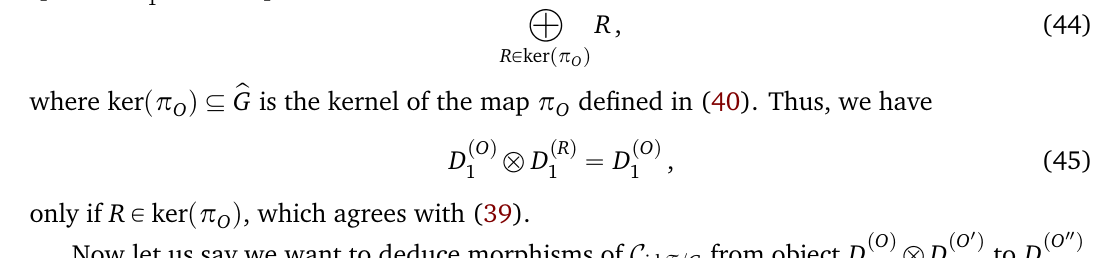
Figure 23: We can relate the morphism space D p O , R O q ter gauging G to the sub-space of the morphism space D p O q gauging G transforming in a specific representation of G determined by the repre- sentations R